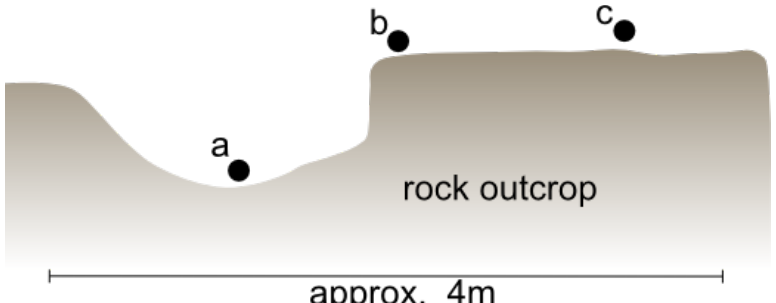
Figure 3. Schematic cross-section of rock outcrop showing different possibilities for the locations of gamma-ray readings. Location (a) would collect readings from an area of >2π so would overestimate results, location (b) is next to a ledge so would collect readings from an area <2π and underestimate gamma-ray counts. Location (c) is a relatively flat section of outcrop more than a meter away from ledges; this would likely be a 2π area where the results are not affected by